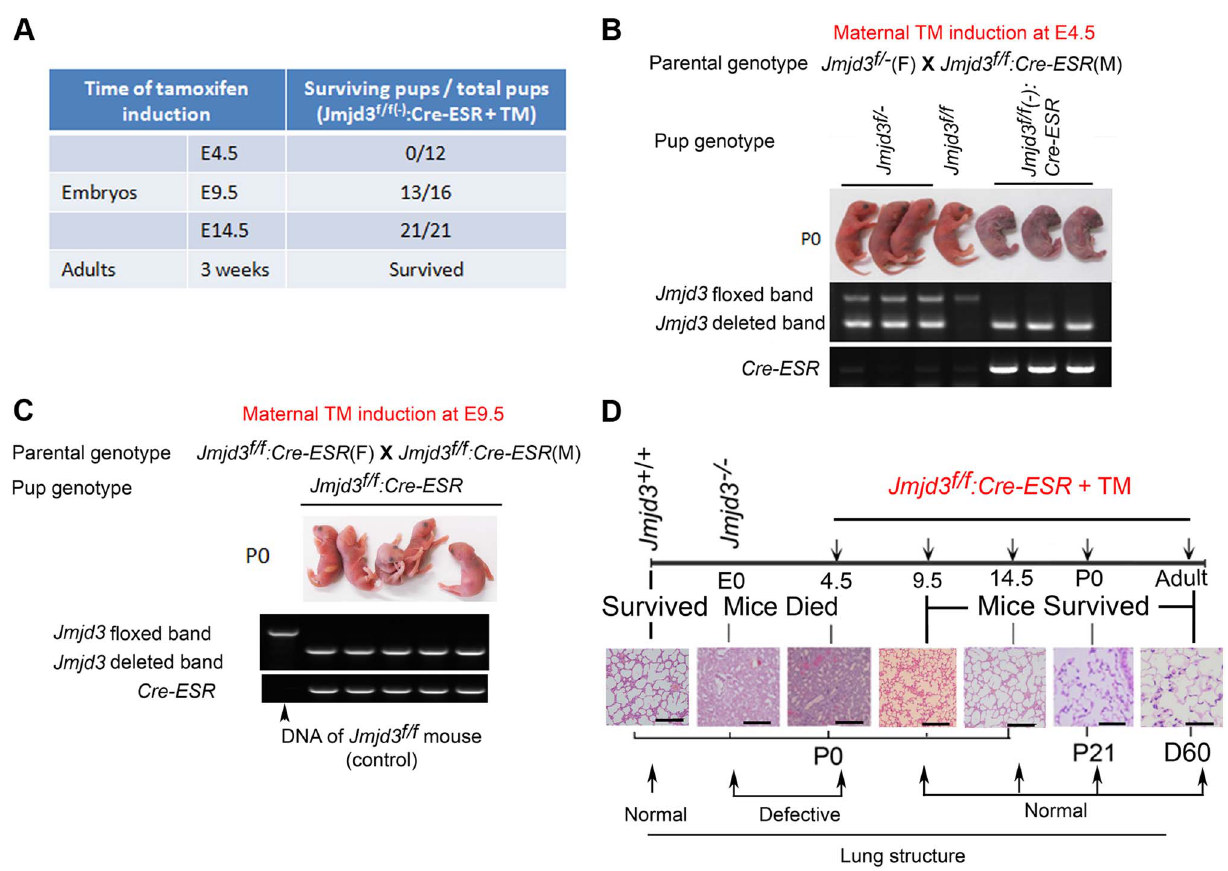
Figure 3. Stage-specific deletion reveals that Jmjd3 is dispensable for lung development in later E9.5 embryonic stage. ( A ) Jmjd3 f/f mice were crossed with CAG-Cre/ESR mice in which Cre expression is globally induced with TM. The survival of Jmjd3 f/f :Cre/ESR pups from maternal mice treated with TM at E4.5, E9.5, and E14.5 was determined. ( B ) PCR analysis of Jmjd3 deletion efficiency in Jmjd3 f/f :Cre/ESR pups from maternal mice treated with TM at E4.5. ( C ) PCR analysis of Jmjd3 deletion efficiency in Jmjd3 f/f :Cre/ESR pups from maternal mice treated with TM at E9.5. ( D ) H&E staining showing the stage-dependent effects of Jmjd3 deletion on lung architecture and its correlation with embryo viability. Bar=500 m m.